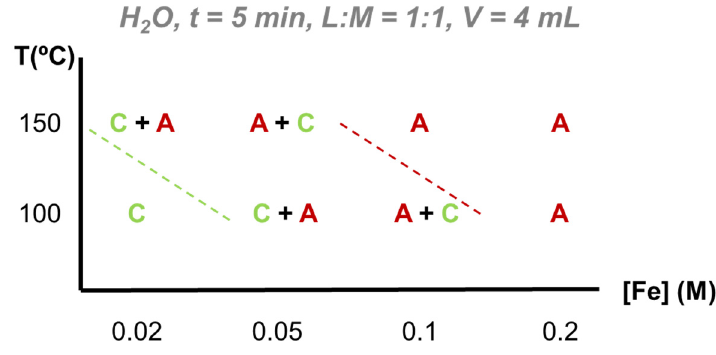
Figure 1. Crystallization diagram for the microwave (MW)-assisted hydrothermal synthesis of the system FeCl 3 /H 2 BDC-NH 2 in water based on powder X-ray diffraction (PXRD) data. Legend: A = MIL-53-NH 2 , B = MIL-88B-NH 2 , C = MIL-101-NH 2